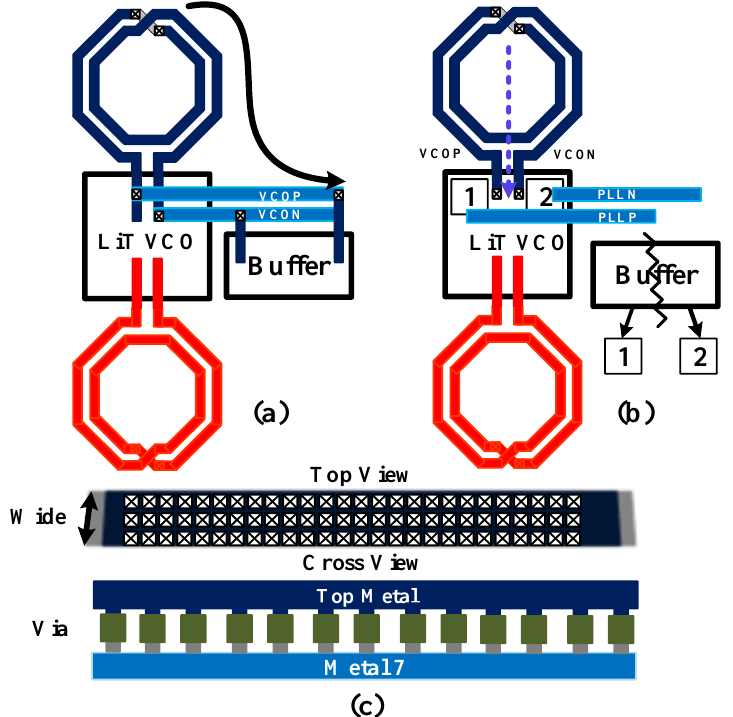
Figure 7. ( a ) Layout of VCO core and buffer are separated, ( b ) the utilized technique for shrinking the routing and improving phase noise performance, ( c ) simplified layout pattern of the VCO routing.